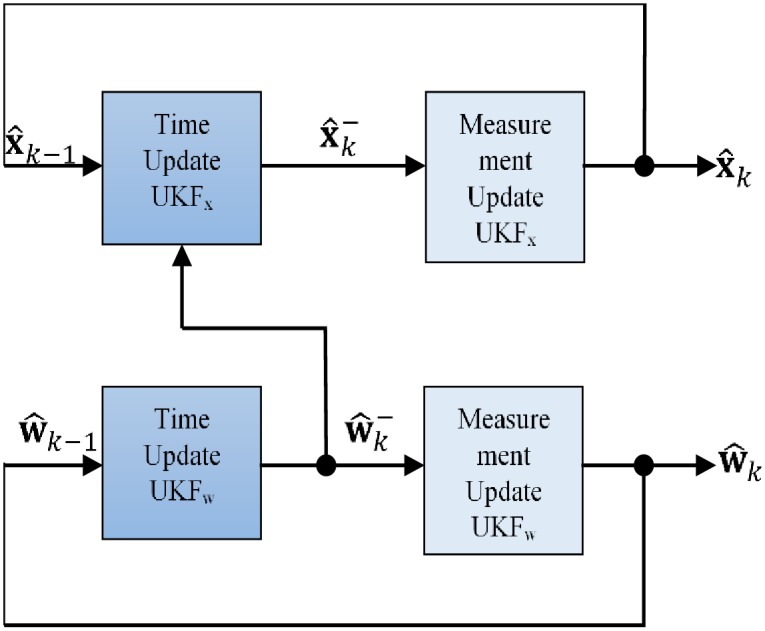
Dual estimation.